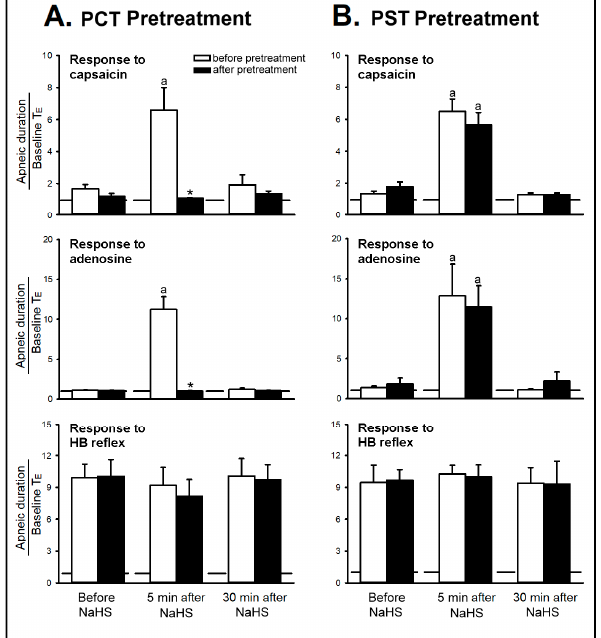
Figure 4. Effect of ( A ) perineural capsaicin treatment (PCT) and ( B ) perineural sham treatment (PST) on the enhancing effects of sodium hydrosulfide (NaHS) inhalation on apneic responses to right-atrial injections of capsaicin (1 μ g/kg), adenosine (1.2 mg/kg) and Hering–Breuer (HB) reflex in six groups of anesthetized, spontaneously breathing rats. Data are means ± SE of six rats. a , significantly different from before NaHS ( p < 0.05); *, significant difference when corresponding data between before and after pretreatment were compared ( p < 0.05).